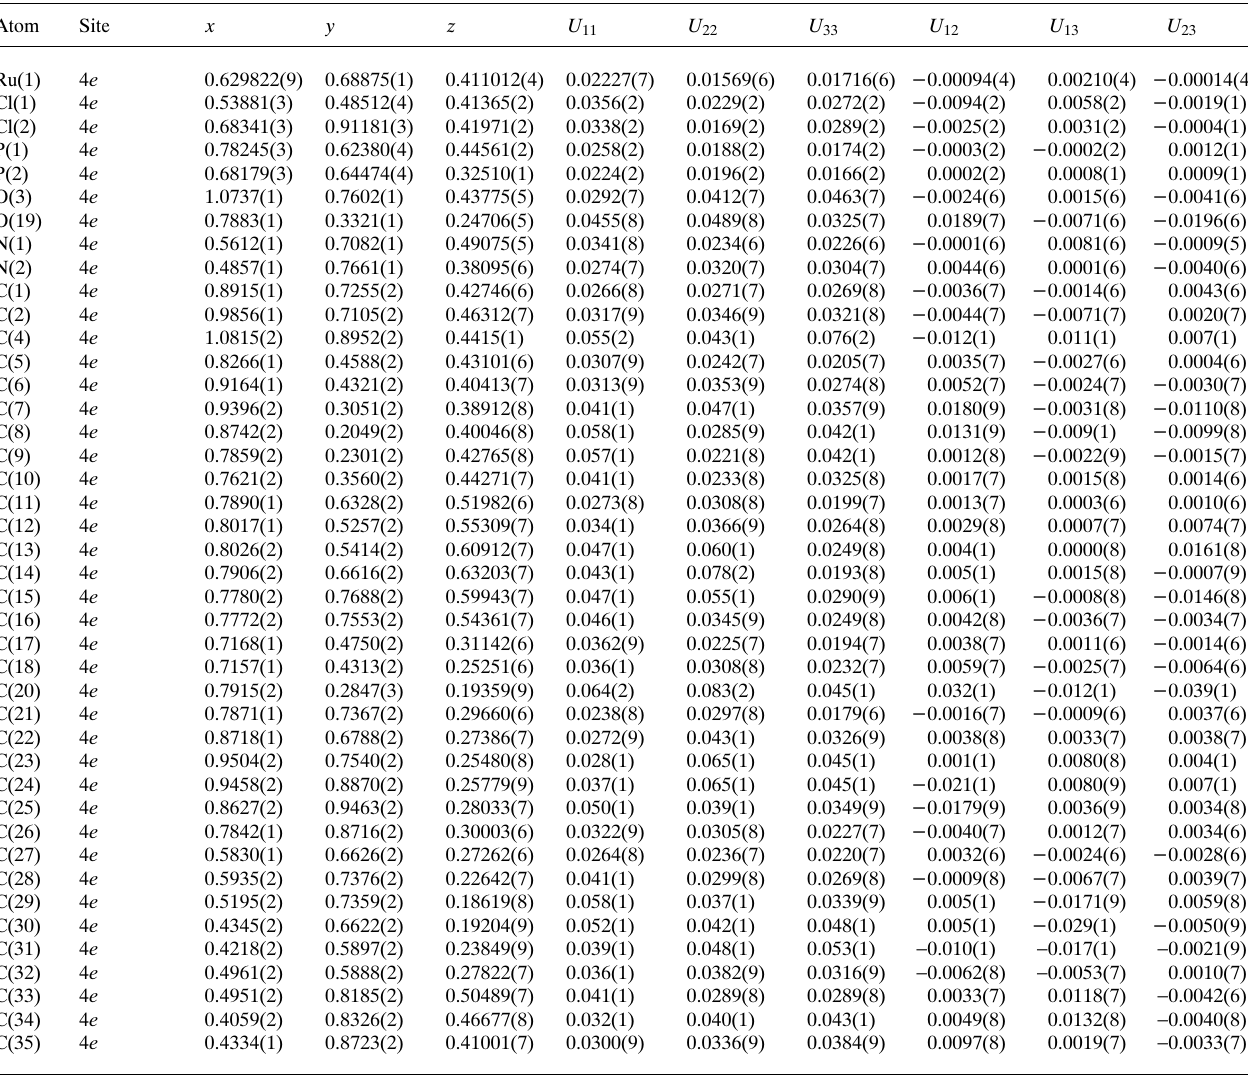
Table 3. Atomic coordinates and displacement parameters (in Å 2 ) .